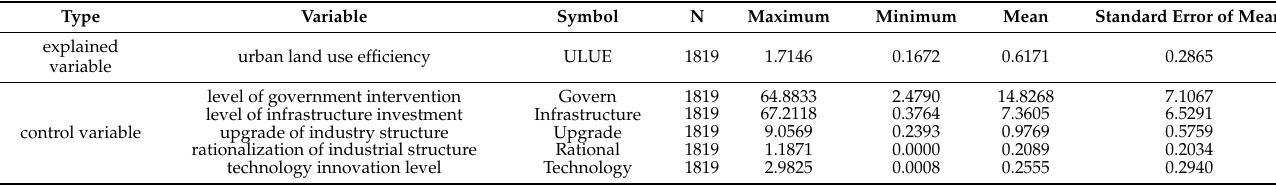
Table 1. Descriptive analysis of the